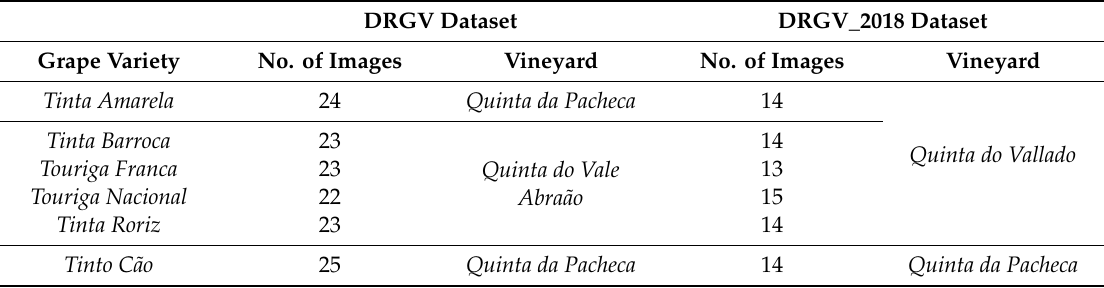
Table 1. Distribution of the images per grape variety captured in the 2016 and 2018 harvest seasons.